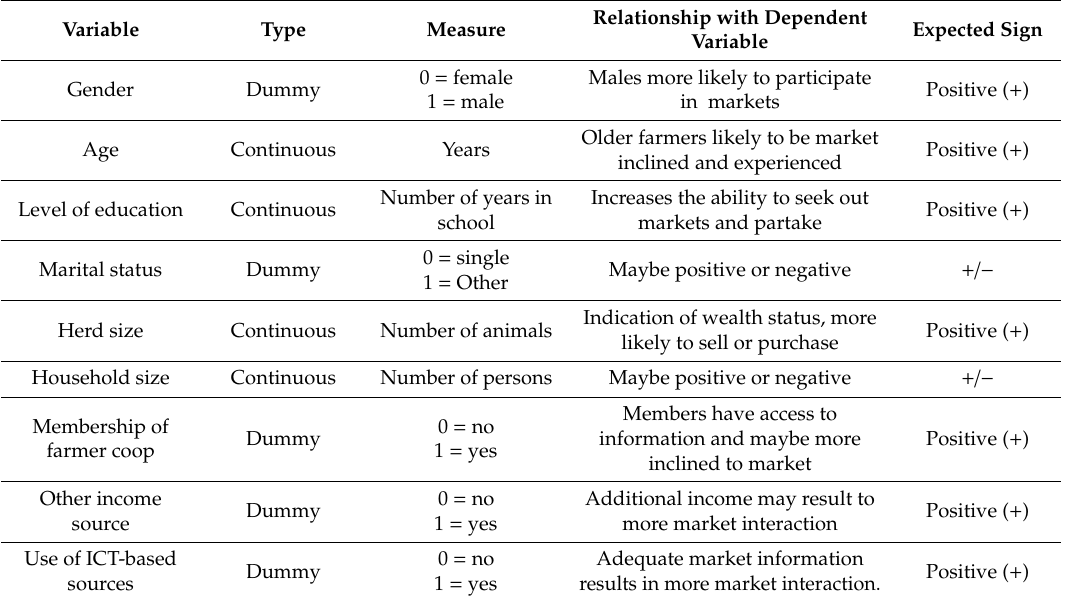
Table 1. Variables in the model and their hypothesized